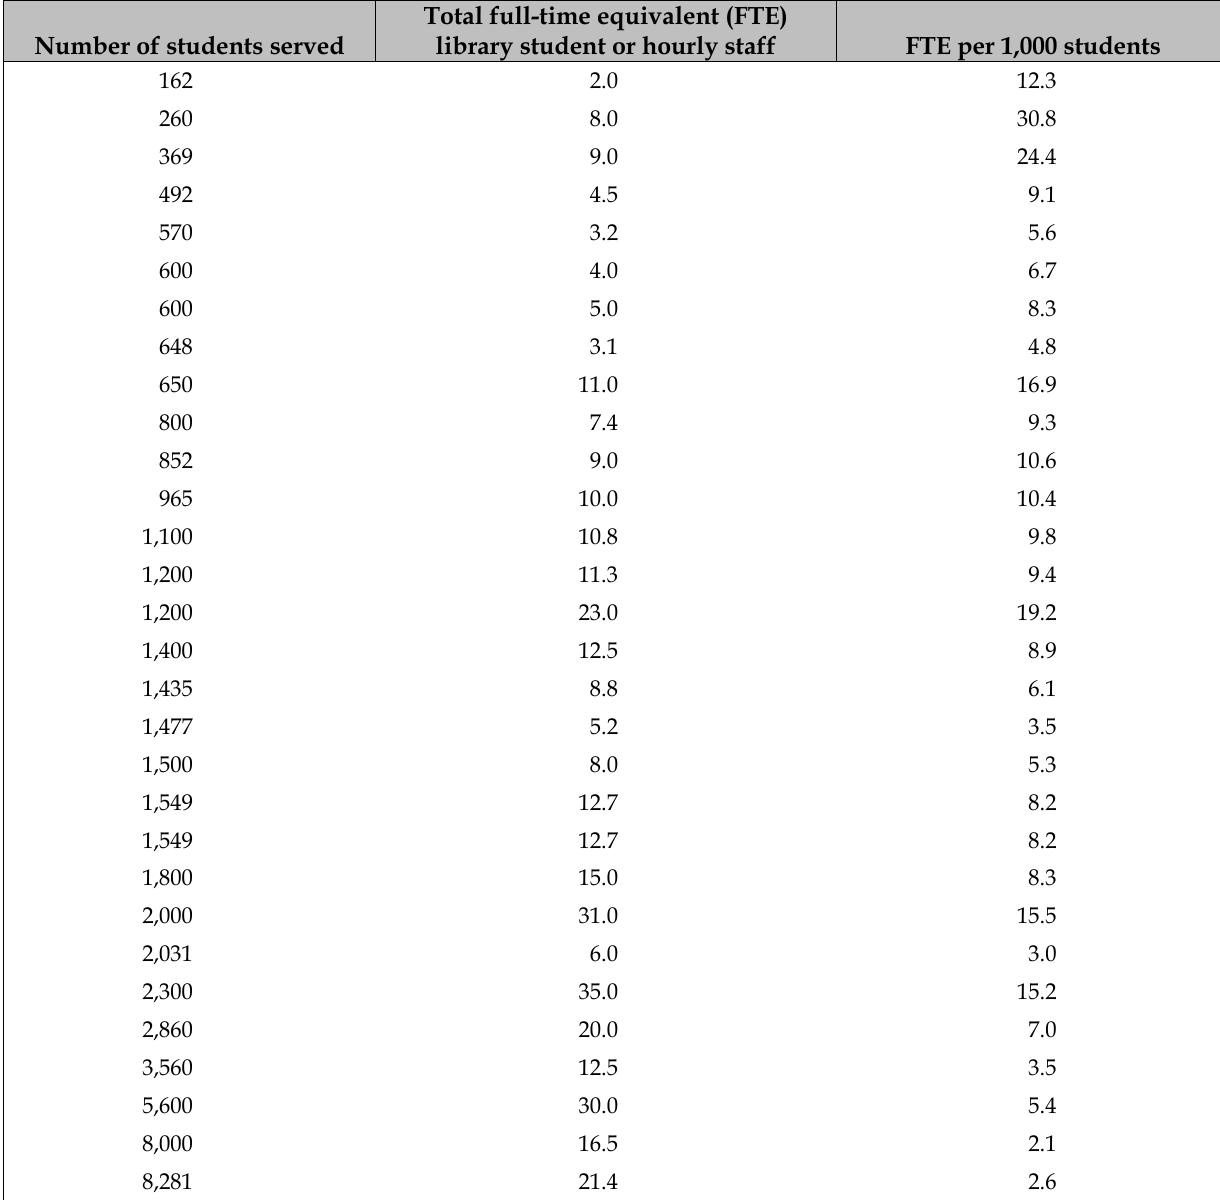
Table 1 Number of students served, total full-time equivalent (FTE) library student or hourly staff, and FTE per 1,000 students Total full-time equivalent Number of students served